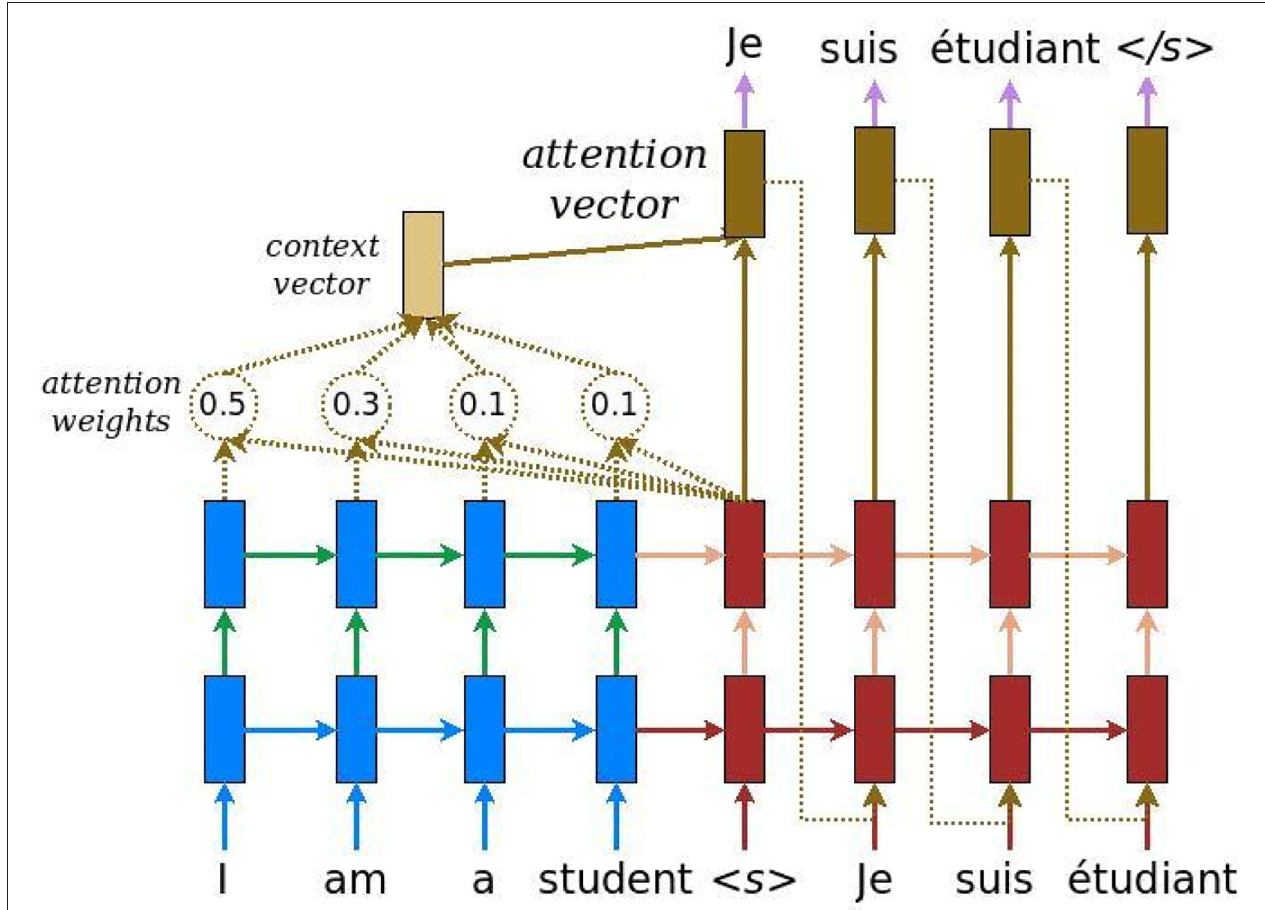
FIGURE 1 | Attention mechanism. Example of translation from English ( I am a student ) to French ( je suis un étudiant